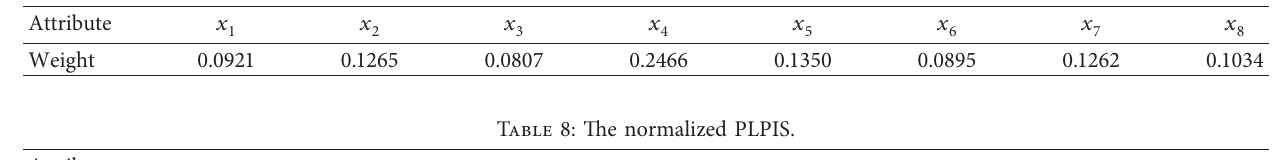
Table 7: The weights of the attributes.